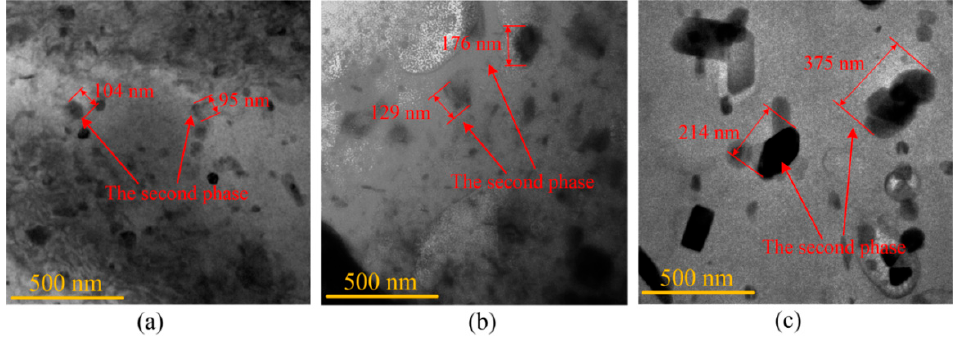
Figure 16. The distribution of the second phase particles: ( a ) 200 °C; ( b ) 300 °C; ( c ) 400